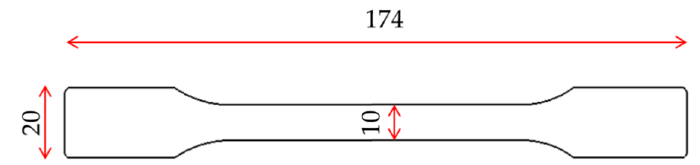
Figure 2. Moulded part geometry, thickness is 4 (dimensions in millimetres).